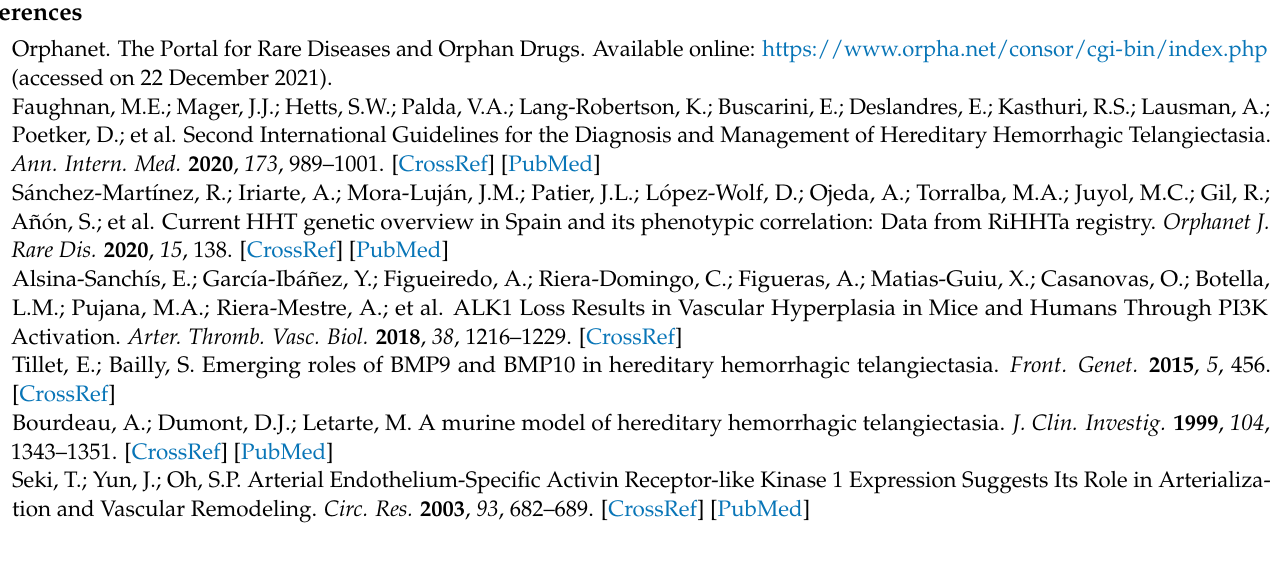
mouse skin; Figure S4: (a) Adrenomedullin antibody and (b) GAPDH antibody in mouse colon; Table S1: Band quantification in mouse lung; Table S2: Band quantification in mouse cerebellum; Table S3: Band quantification in mouse skin; Table S4. Band quantification in mouse